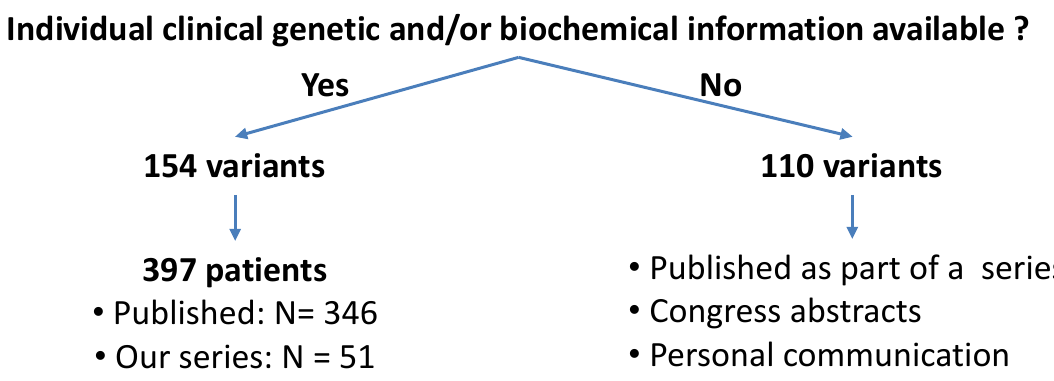
Figure 1. Steps leading to the identification of patients with sequence variants in the MVK